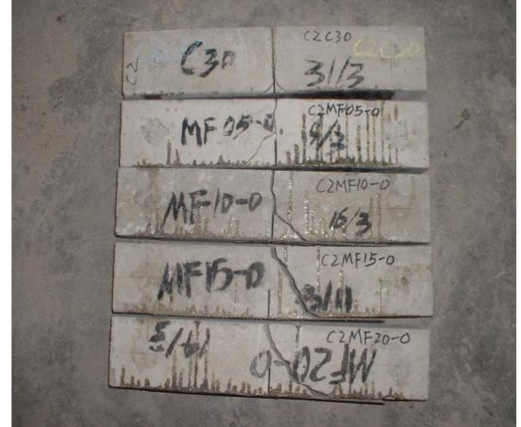
Figure 4. The failure of OC.